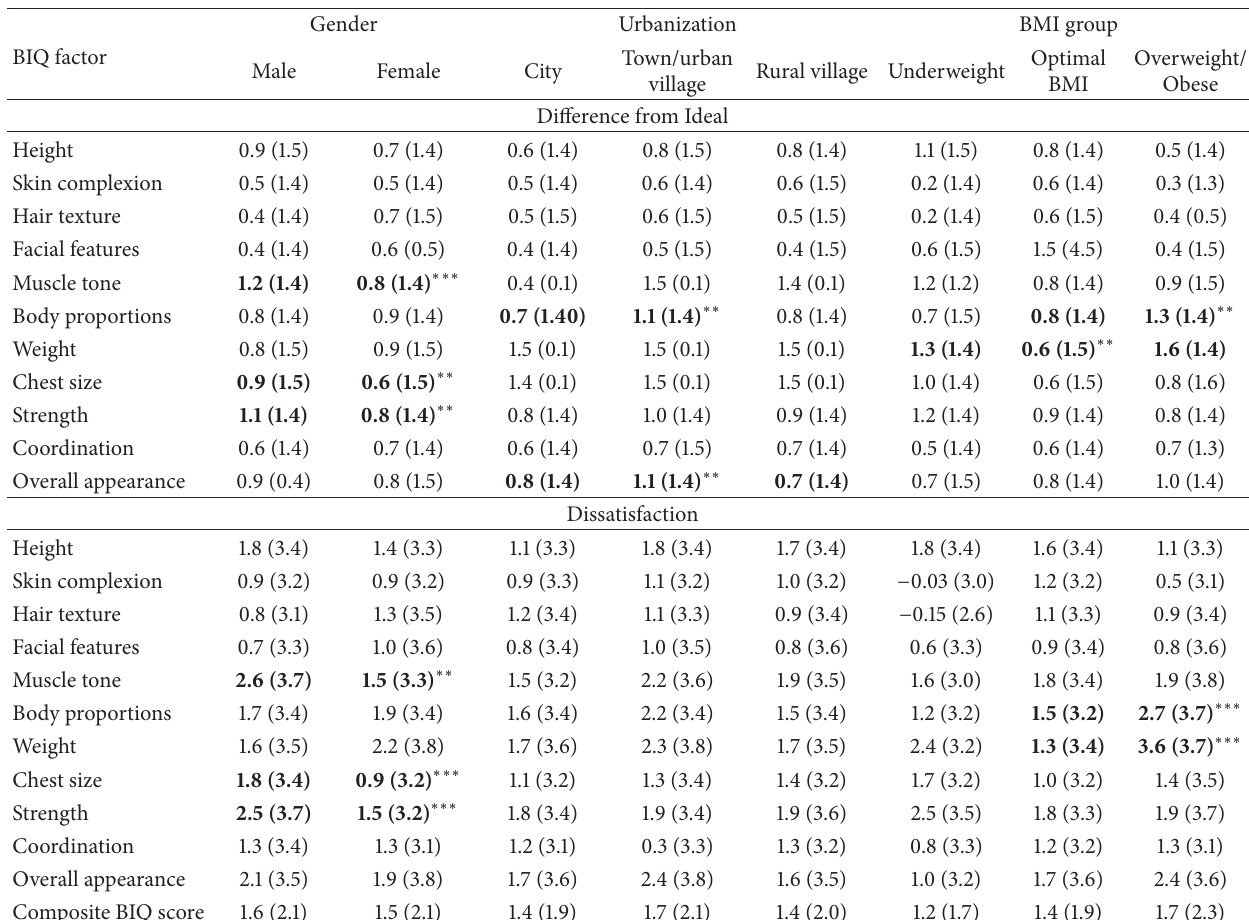
Table 3: Body Image Questionnaire difference from ideal and dissatisfaction